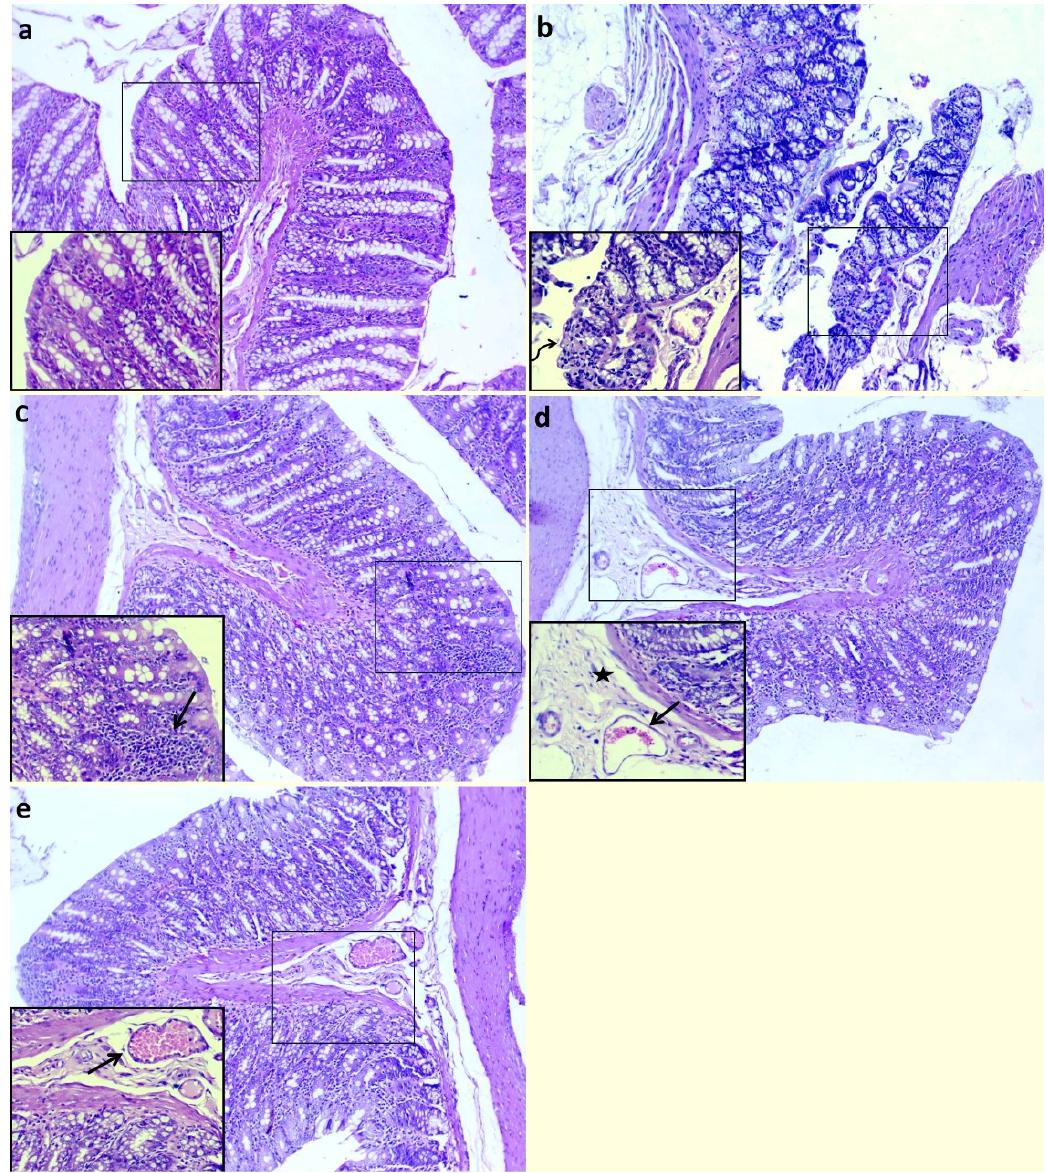
Figure 3. Impacts of quercetin-loaded nanoparticles (QT-NPs) therapy on histopathological lesion. Control: healthy non-colitic group (rats orally gavaged with PBS, ( a )) showing normal histological structures of columnar epithelial lining mucosa with goblet cells, submucosa, muscular layer and serosal layer. Colitic groups: DSS (rats orally gavaged with dextran sodium sulphate, ( b )) showing necrotic lamina epithelialis (arrow) represented by coagulative necrosis of epithelium admixed with leukocytic infiltrates (curved arrow); DSS + QT-NPsI (rats orally gavaged with DSS and quercetin-loaded nanoparticles (QT-NPs at the level 10 mg/kg body weight for 14 days), ( c )) showing preserved structures of colon layers with presence of inflammatory cells infiltrates within lamina propria; DSS + QT-NPsII (rats orally gavaged with DSS and quercetin-loaded nanoparticles (QT-NPs at the level 15 mg/kg body weight for 14 days), ( d )) showing edema (star) with mildly dilated blood vessels (arrow) within submucosal layer; and DSS + QT-NPsIII (rats orally gavaged with DSS and quercetin-loaded nanoparticles (QT-NPs at the level 20 mg/kg body weight for 14 days), ( e )) showing preserved structures of mucosa, submucosa, musculosa and serosa in addition to dilated submucosal blood vessels (arrow). All groups orally gavaged by 3% DSS. Magnification: large micrographs are 100 × and smaller ones in the lower left corner are 400 ×